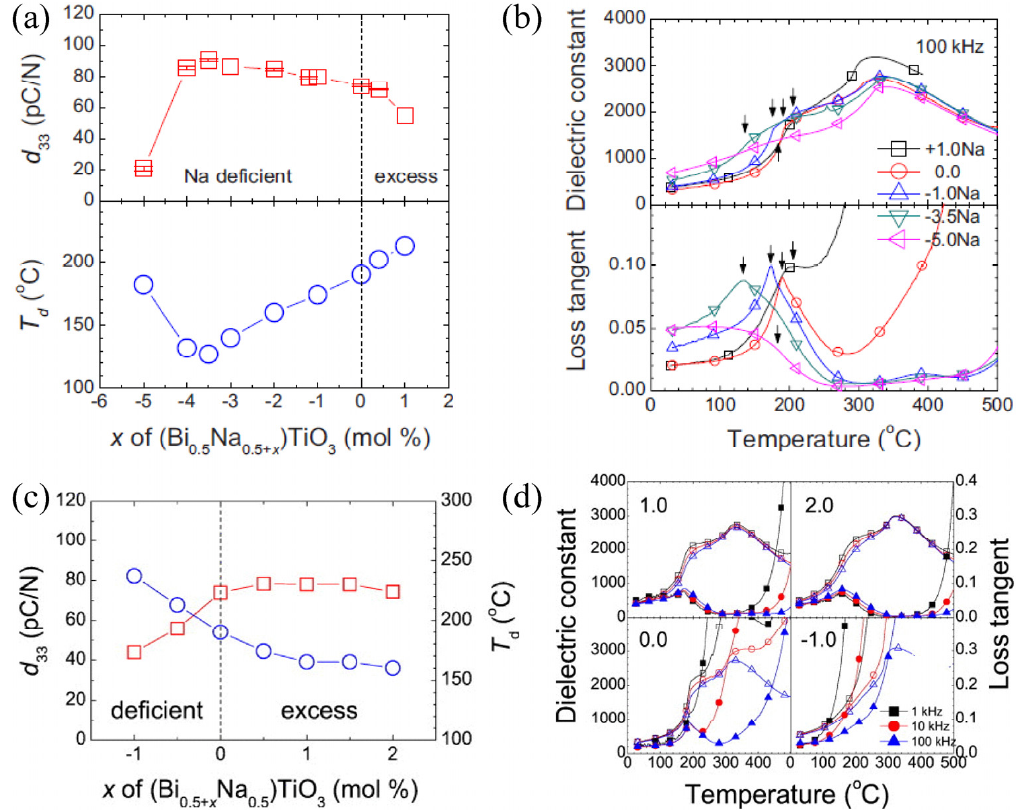
Figure 4. Influence of ( a , b ) Na and ( c , d ) Bi nonstoichiometry on depolarization temperature ( T d ), d 33 , relative permittivity and loss tangent (Reprinted with permission from references [96,97] Copyright from American Institute of Physics 2010, 2011).